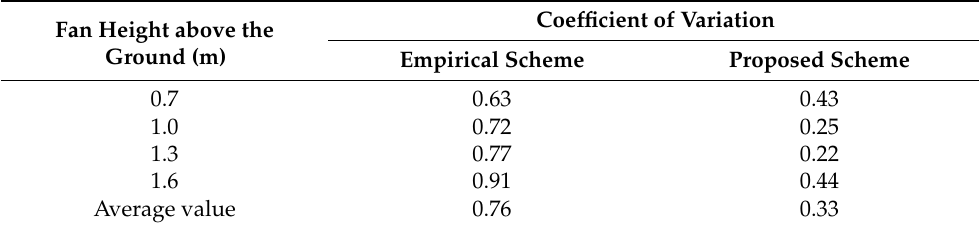
Table 6. Comparison of coefficients of variation for the proposed and traditional empirical system layouts. Coefficient of Variation Fan Height above the Ground (m) Empirical Scheme Proposed Scheme 0.7 0.63